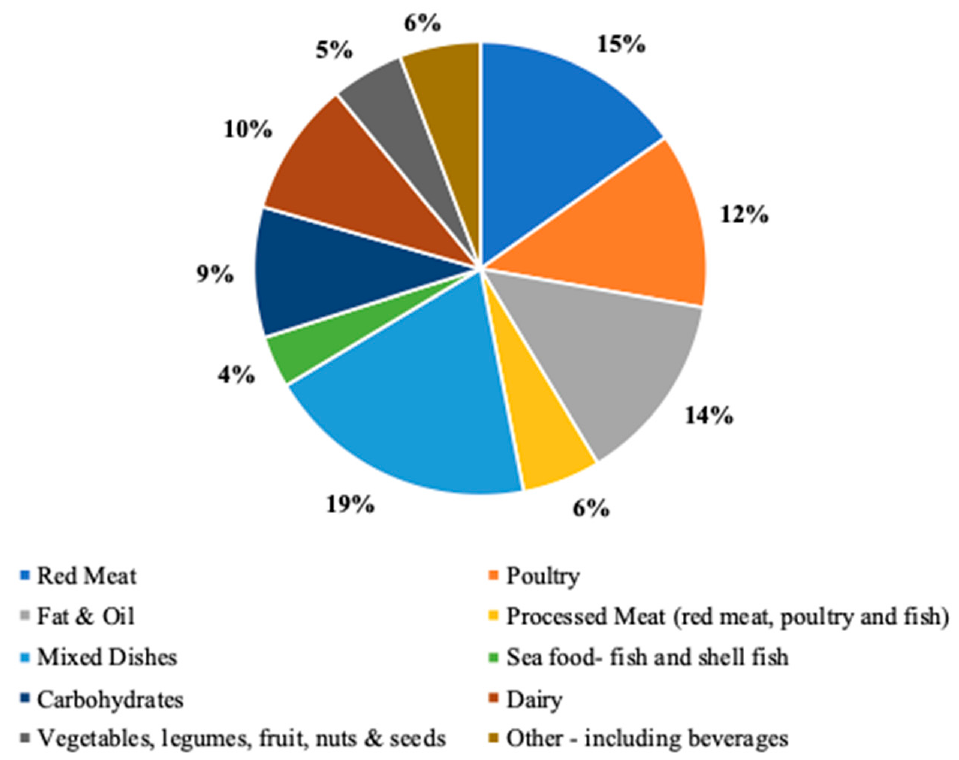
Figure 3. Percent level of food groups that contributed to CML-AGE intake amongst this sample size. Mixed dishes, red meat, fat & oil, poultry, and dairy contributed most in ascending order. A series of unconditional logistic regression models were conducted to determine the association between CML-AGE intake and adenoma recurrence in the sample (Table 2). At trial completion, there were a total of 940 recurrent adenoma cases. There were no significant associations between higher CML-AGE intake and adenoma recurrence in the unadjusted model or simple model adjusting only for age and sex. After adjusting for multiple covariates, there was no significant association between a higher intake of CML- AGE and adenoma recurrence with an OR of 1.02 (95% confidence interval 0.71, 1.48) for participants in the highest quartile compared to the lowest